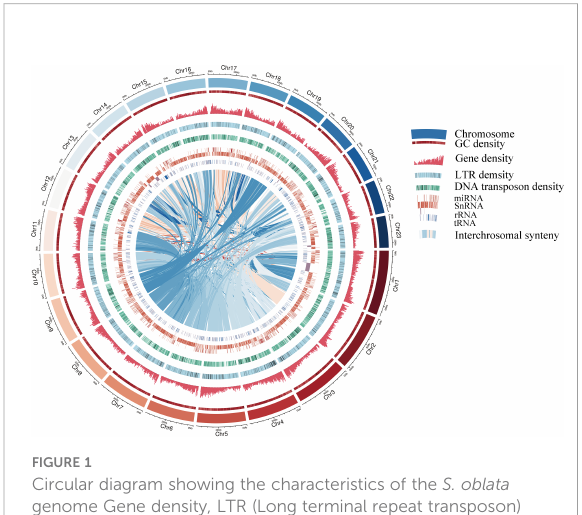
Table 1 The major characteristics of S. oblata genome.